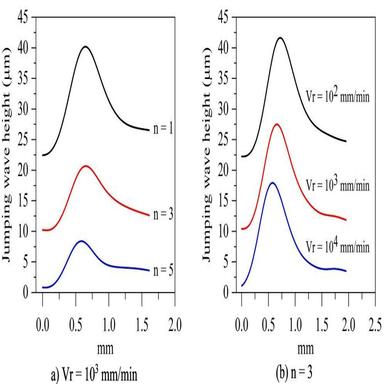
Effect of the burnishing parameters on jumping wave: (a) burnishing passes (b) burnishing speed.